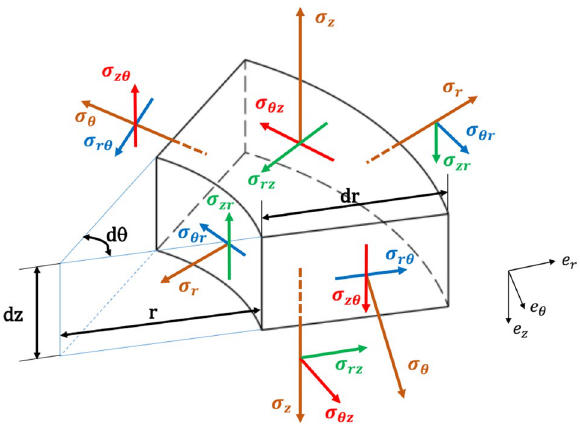
Fig. 1 The cylindrical element of components